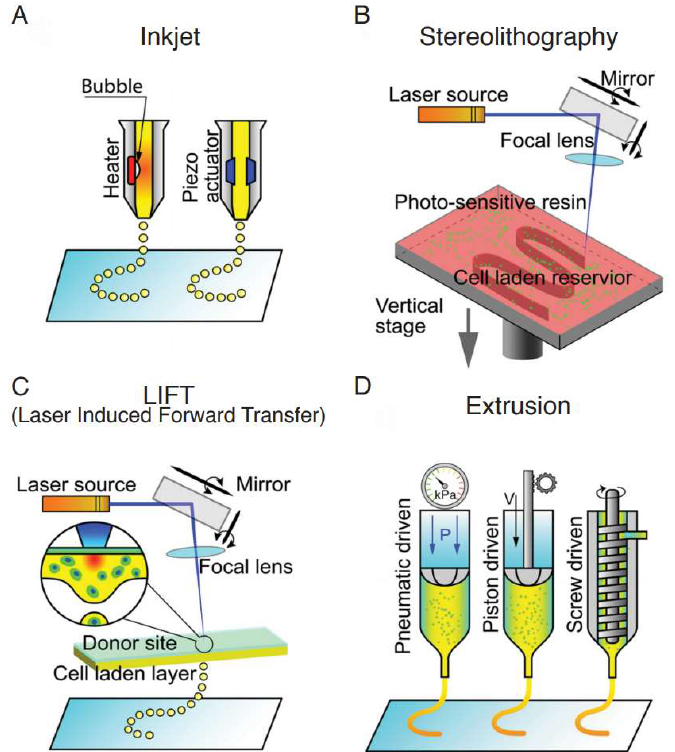
Figure 1. Schematic of various 3D printing methodologies. ( A ) Inkjet. A heater or piezo actuator deposits droplets. ( B ) Stereolithography. Layer by layer photopolymerization of a liquid resin by laser. ( C ) Laser induced forward transfer. Droplets of the material induced by a laser source. ( D ) Extrusion. Material exiting a nozzle that is pneumatic, piston, or screw driven. Reproduced with permission from [7].